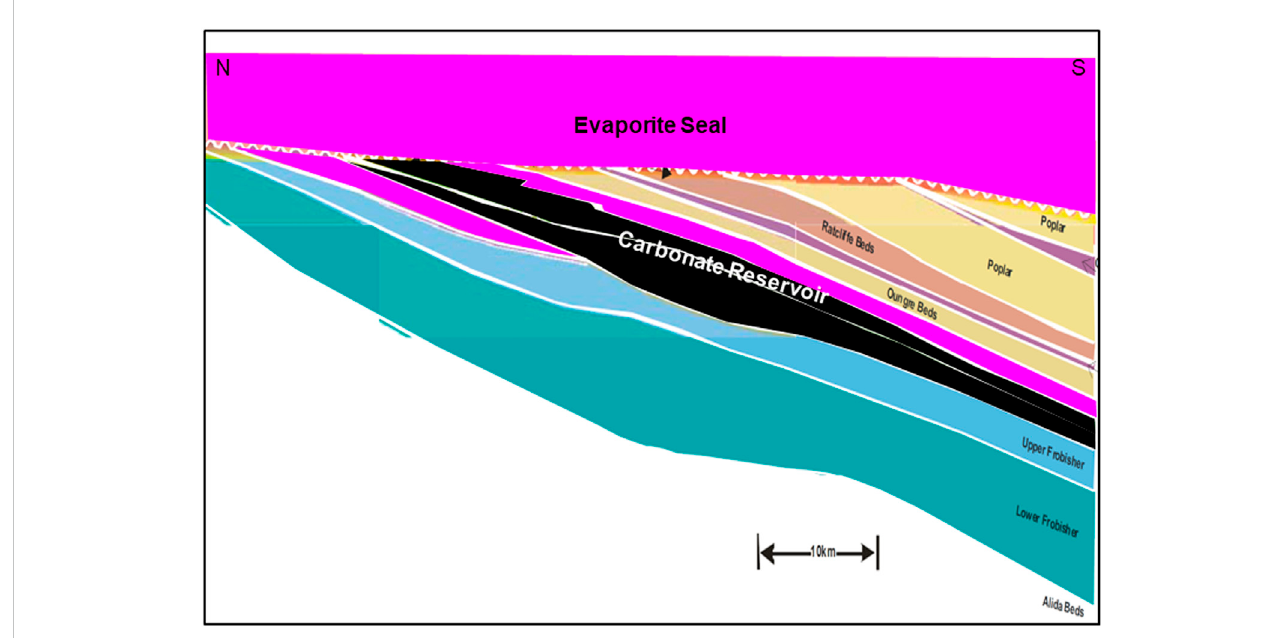
FIGURE 5 Simpli fi edrepresentationofthegeologicalcon fi guration oftheWeyburn CO 2 -EOR siteinCanada. Carbonate reservoirsareshadedblack.Evaporiteseal unitsareshowninmagenta.InsetshowshowCO 2 fl oodingisforecastedtorecoveradditionaloilvolumesextendthe fi eldlife(Modi fi edafterWhittaker,2005; Erikson, 2020).